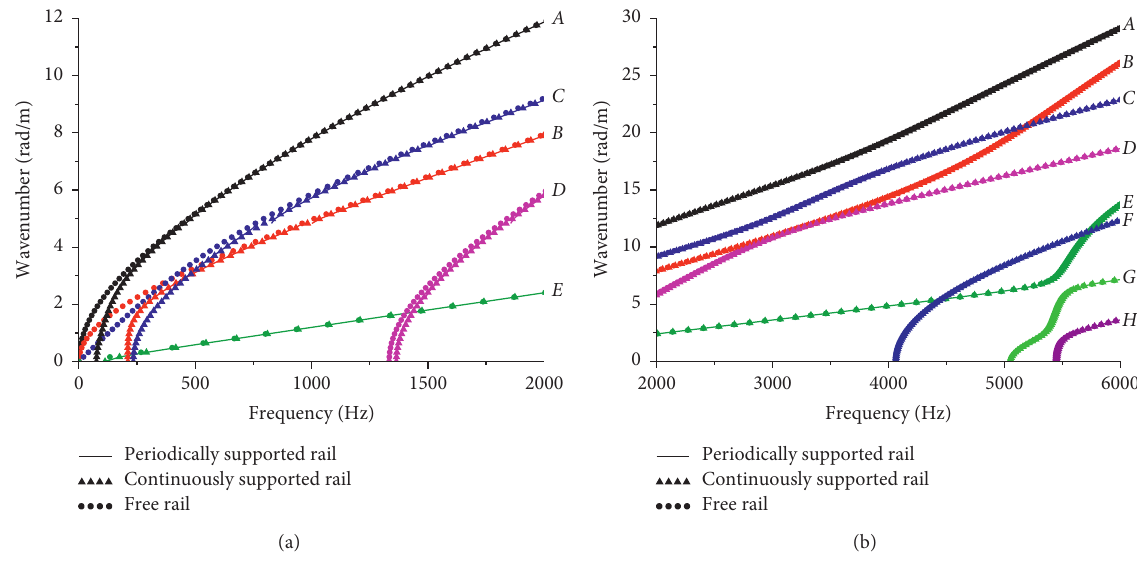
Figure 5: Dispersion curves of different support conditions: (a) 0–2000Hz; (b) 2000–6000Hz.